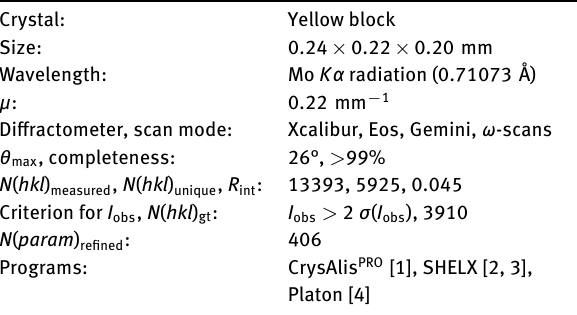
Table 1: Data collection and handling.